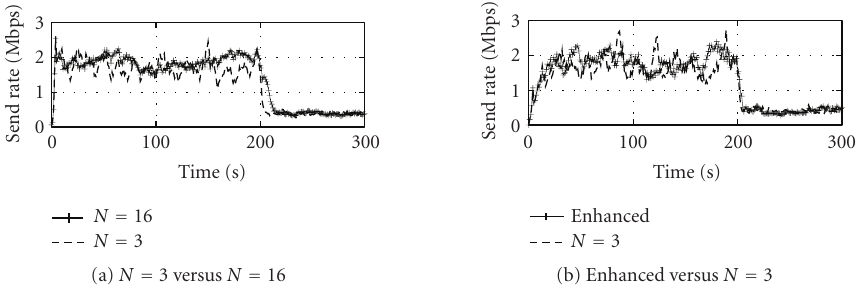
Figure 3: Performance comparison between TFRCC-W flows with di ff erent values of N .